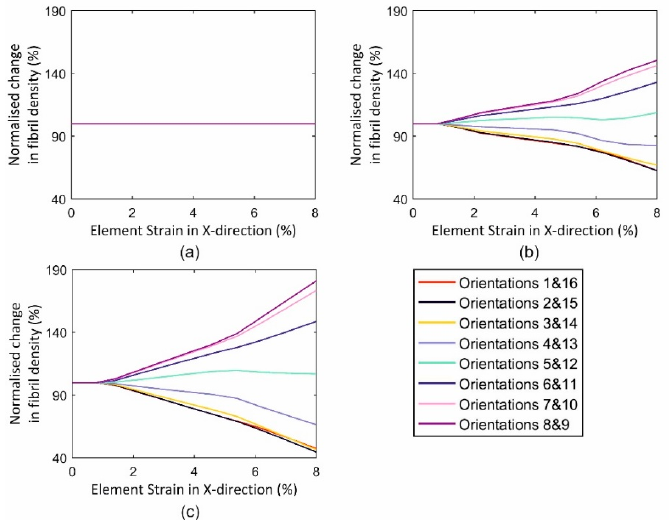
Figure 9. Changes in fibril density in 16 orientations in single-element models subjected to three distinctive displacement loading cases: ( a ) U1 = 0.8 mm and U2 = 0.8 mm, ( b ) U1 = 0.8 mm and U2 = 0.4 mm, and ( c ) U1 = 0.8 mm and U2 = 0.0.